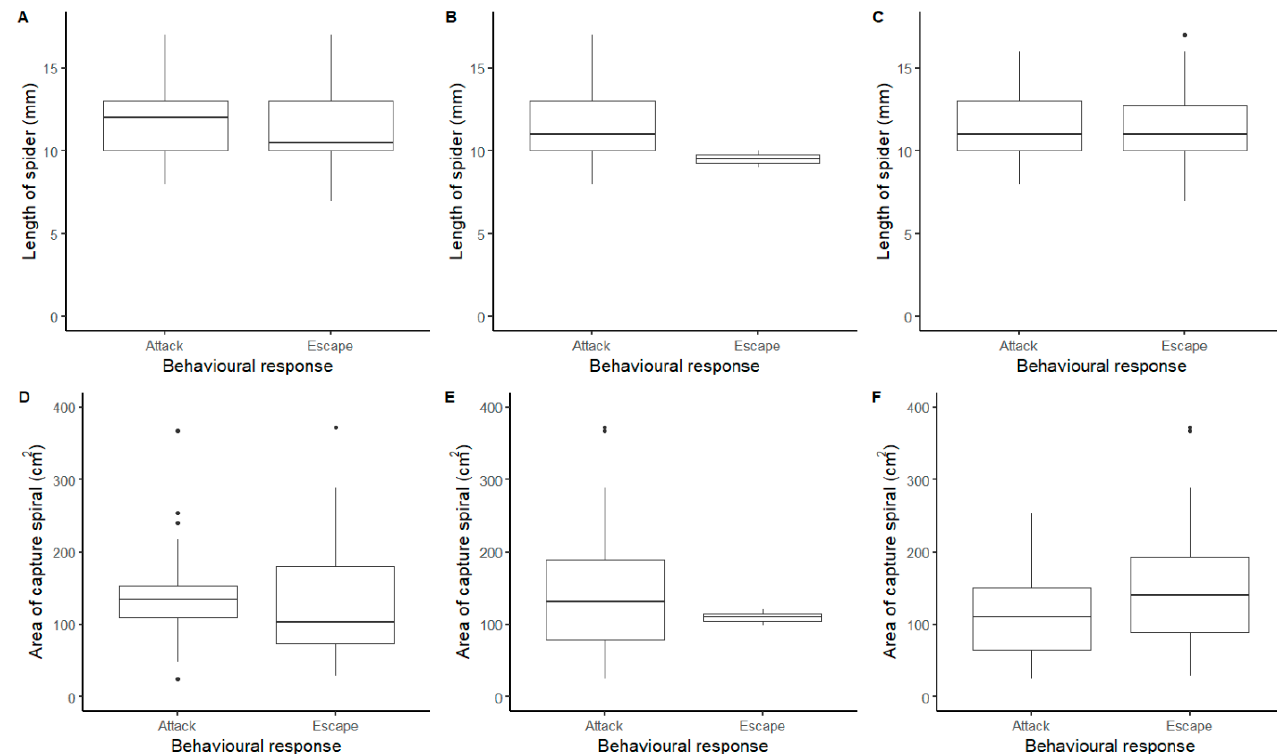
Figure 3. Comparison of the length of the spider (mm) and the area of the capture spiral (cm 2 ) against the behavioural responses observed in Metellina segmentata. ( A , D ) 256 Hz tuning fork; ( B , E ) 440 Hz tuning fork; ( C , F ) length of wire.